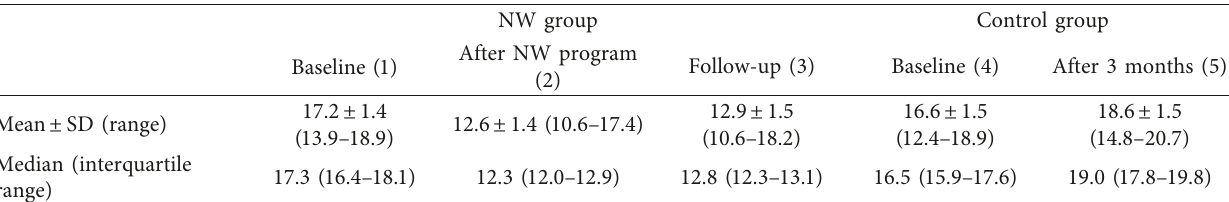
Figure 2: Timed Up and Go Test results in the NW and control groups at different timepoints. Table 5: Timed Up and Go